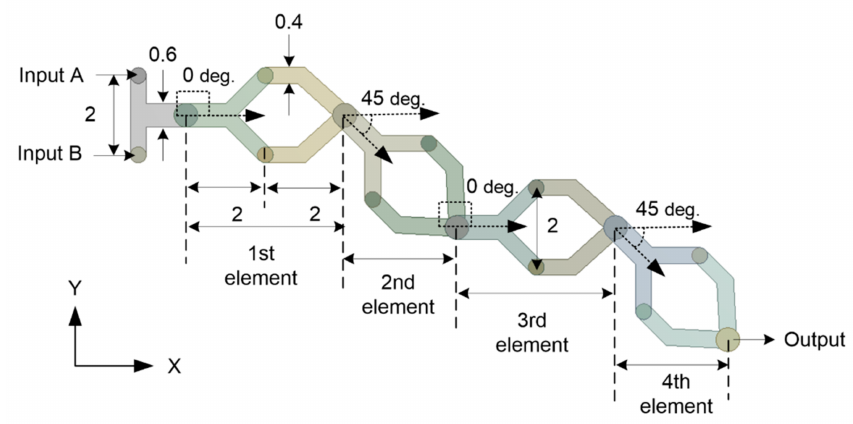
Figure 2. Diagram of the ( Y − U )